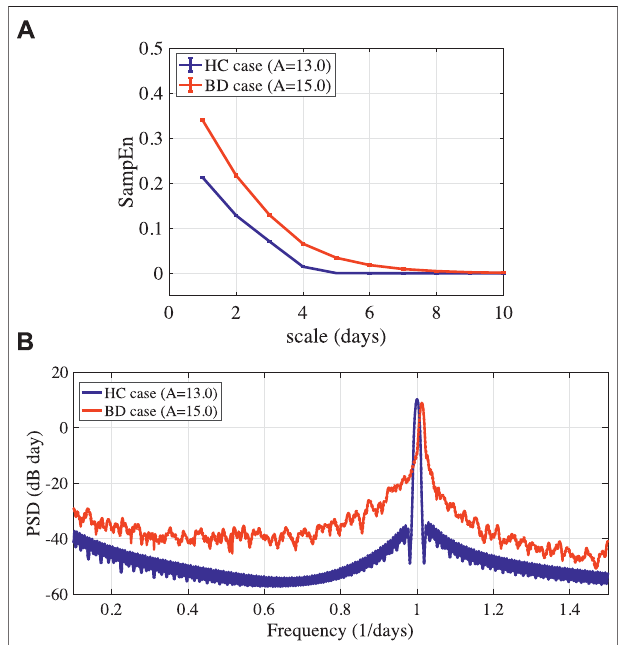
FIGURE 3 | (A) Multi-scale entropy analysis of circadian rhythm output ( k ) given by Eq.(8) in healthy controls ( A (cid:1) 13 . 0) and bipolar disorder (BD) ( A (cid:1) 13 . 0) patients. The mean and standard error of the sample entropy (SampEn) in 10 trials are shown by solid line and error bar respectively. (B) Power spectrum density (PSD) ofcircadianrhythm output( k ) inHC and BD cases. The mean and standard error of PSD were indicated by solid and dotted lines, respectively. Due to the disturbed circadian rhythms of BD patients, SampEn in the scale ( ( 7 days) and the PSD in ( 1, a 1 [1/day]